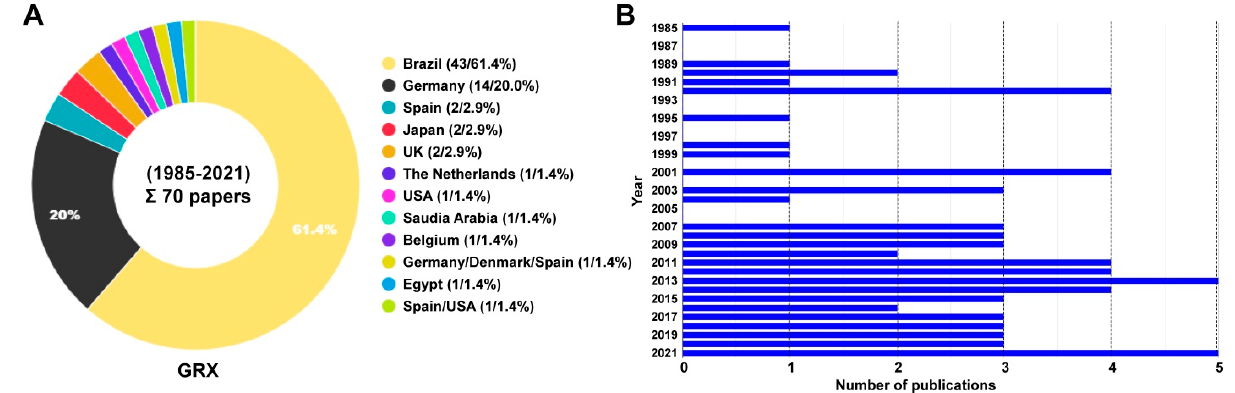
Figure 1. Usage of GRX cells during the period from 1985–2021. ( A ) A total of 70 studies using GRX cells were identified in a PubMed or Google search using search terms “GRX cells” or “GRX and hepatic”. Papers were excluded that used the term ‘GRX’ for other purposes (see Section 2 for details). In total, 69 papers were identified that used GRX cells. Most studies with these cells were conducted in Brazil, Germany, and Spain. The search was done on 5 November 2021. ( B ) Since the first report on GRX cells in 1985, reports using this cell line as an experimental tool steadily increased from year to year. For references on individual studies performed with GRX cells, refer to Table S1.